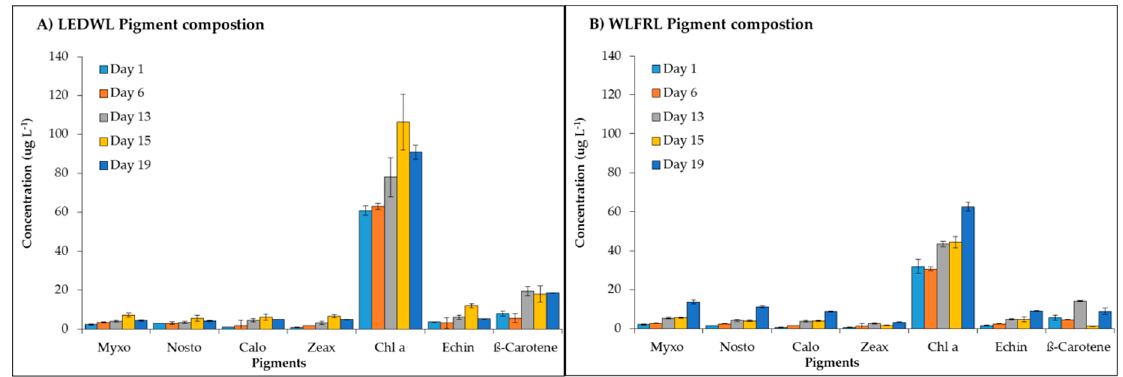
Figure 4. Growth curve of C. fritschii under LED white light (LEDWL) and supplemented LED white light with far-red light (WLFRL).